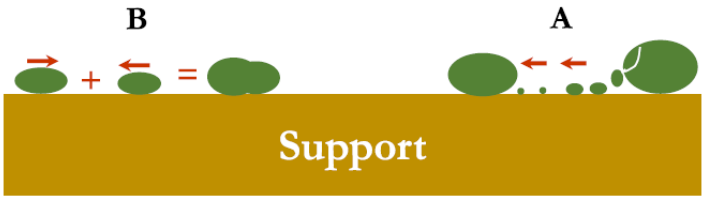
Figure 7. Sintering pathways of catalysts via crystal growth by (A) atomic migration and (B) crystallite migration. Reprinted with permission from Ref. [30]. Copyright 2019 Elsevier.